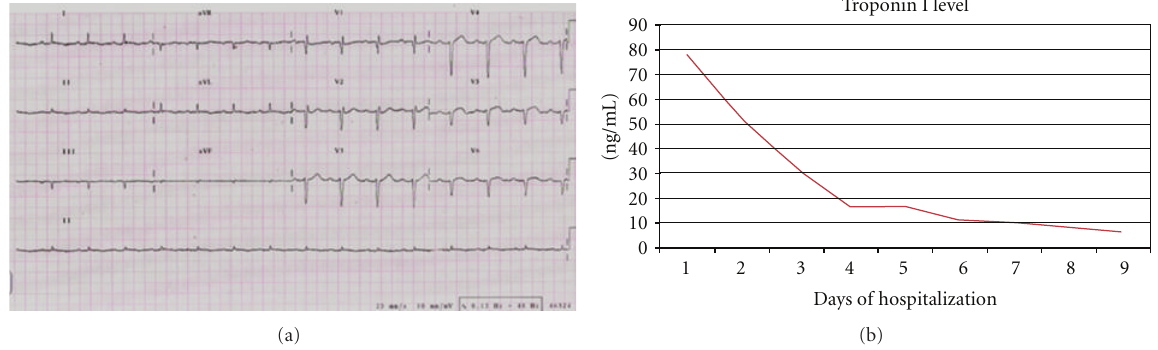
Figure 1: (a) Surface electrocardiogram in sinus rhythm with QS waves in III and aVF, QS waves in V1–V6 elevation of ST segment of < 0.1mv in V3 to V6, atrioventricular first degree block and asymmetric inversion of T wave in I and aVL. (b) Troponin I level evolution during hospitalization.